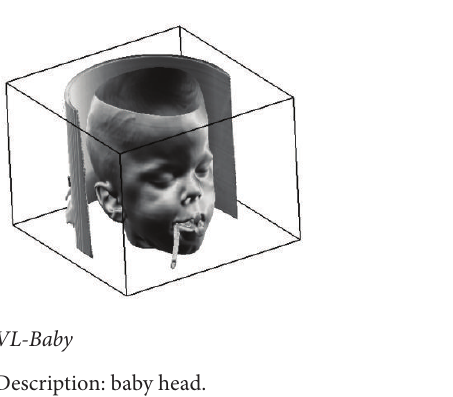
Description: computed tomography of knee, anterior tibial